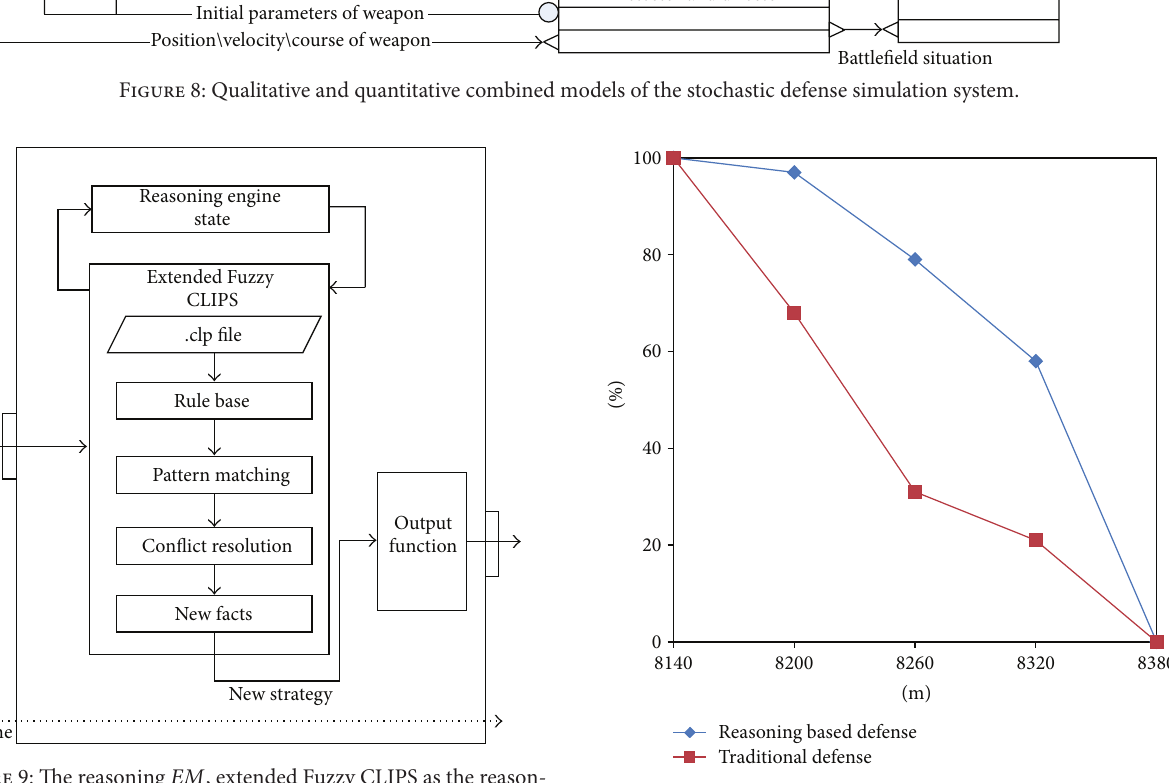
This means that 𝐸𝑀 and 𝐶𝑀 have the same schema, and the 𝐻𝐿𝑀 is